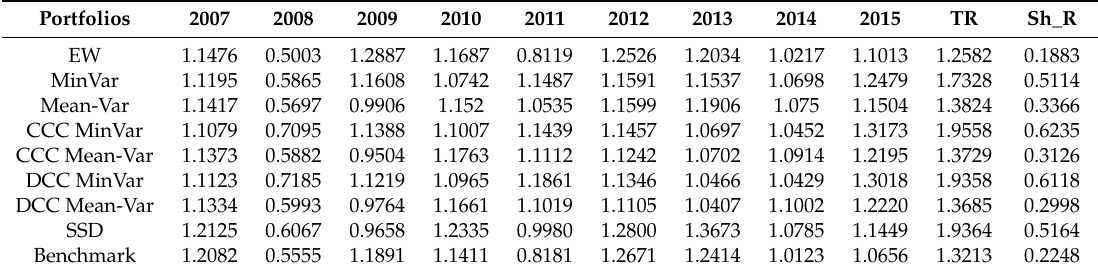
In Table 7 (DAX stocks, t = 750), the SSD constrained portfolio has T_R (1.9364) higher than all except CCC MinVar and DCC MinVar. Table 7. Yearly compounded returns, Total compounded Return (T_R) and Sharpe Ratio (Sh_R) for DAX stocks (t =